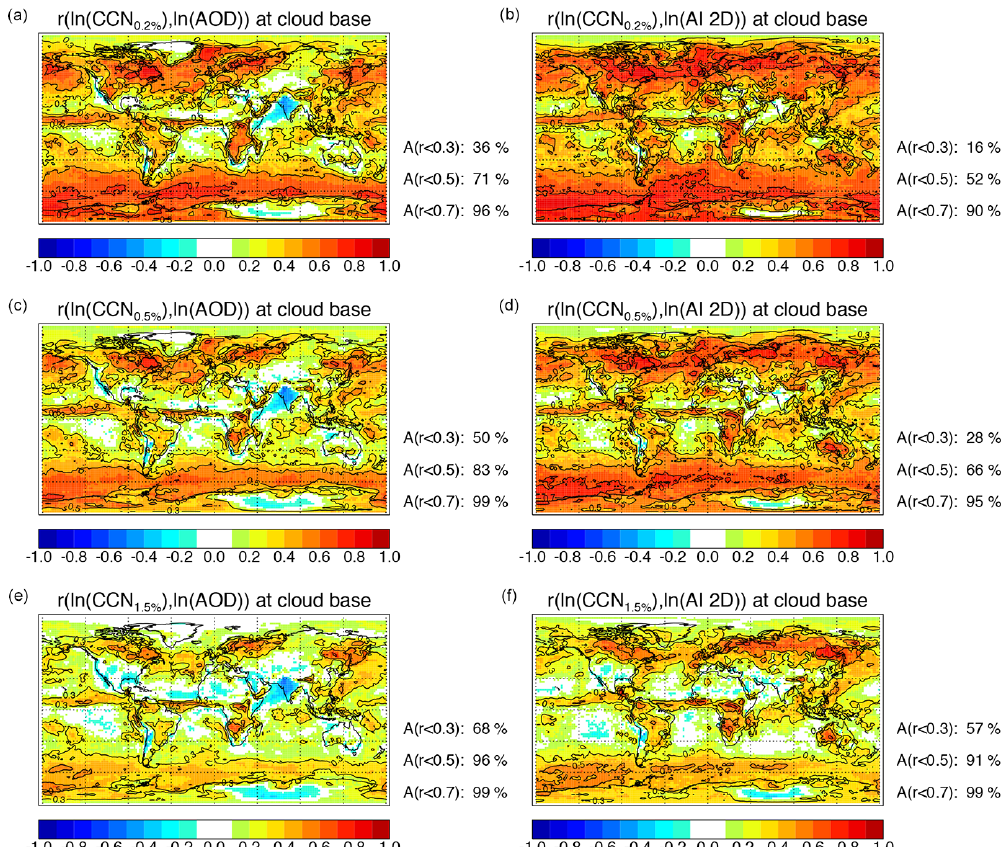
Figure 8. Map of Pearson’s correlation coefficient of ECHAM-HAM simulated cloud base CCN with aerosol radiative properties for (a) CCN 0 . 2% with vertically integrated aerosol optical depth, (b) CCN 0 . 2% with vertically integrated aerosol index, (c) CCN 0 . 5% with vertically integrated aerosol optical depth, (d) CCN 0 . 5% with vertically integrated aerosol index, (e) CCN 1 . 5% with vertically integrated aerosol optical depth and (f) CCN 1 . 5% with vertically integrated aerosol index. Fractional area (A) of the globe with r < 0 . 3, 0.5,